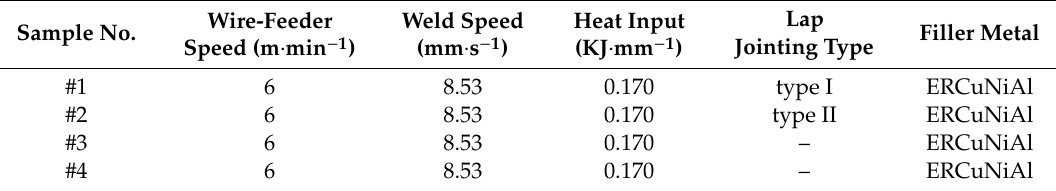
Figure 1. Schematic diagrams of joints ( a ) top Ti sheet-bottom steel sheet lapped joint (joint I) and ( b ) top steel sheet-bottom Ti sheet (joint II). Table 3. CMT welding variables of TA2 and Q235 steel.